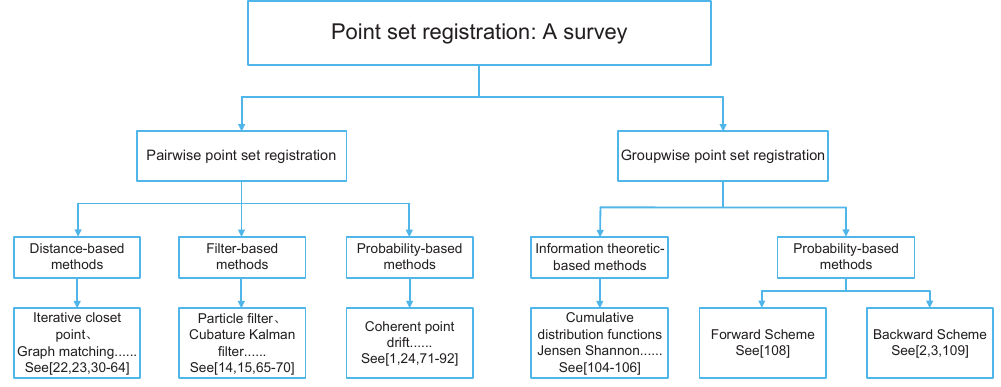
Figure 2. Taxonomy of point set registration